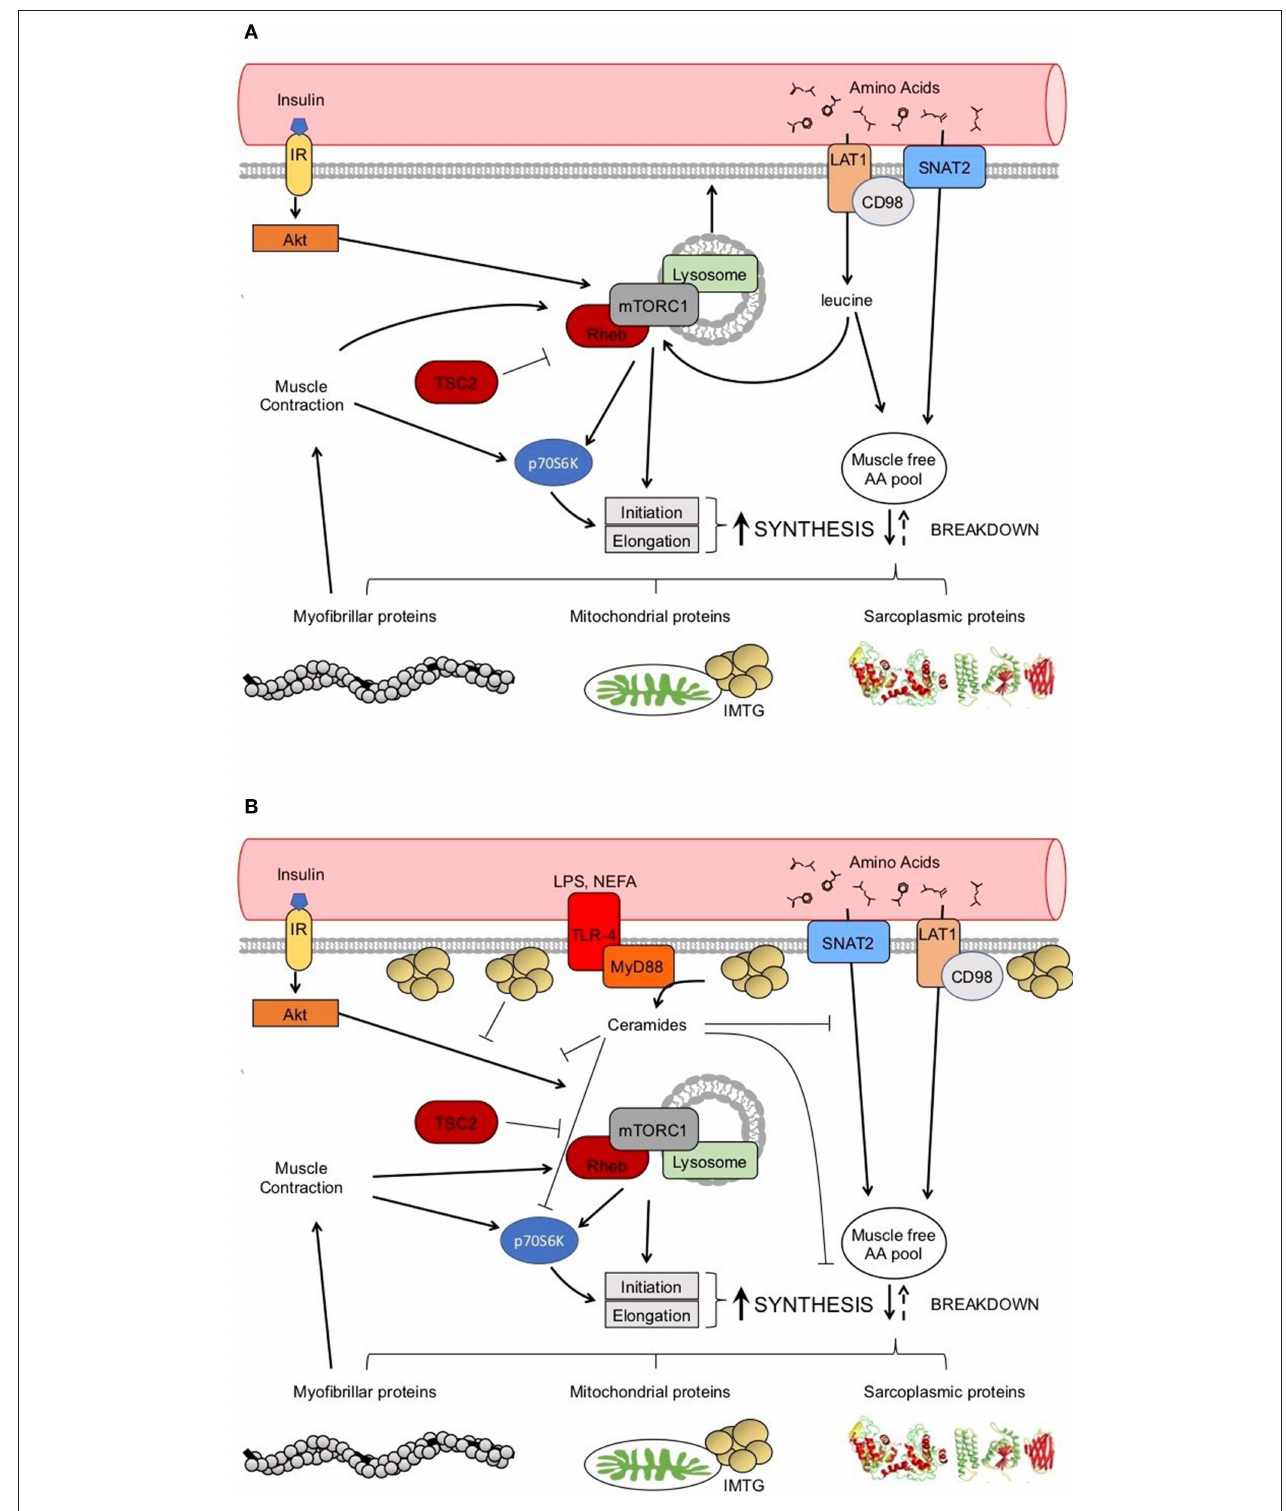
FIGURE 2 | Healthy anabolic signaling in the skeletal muscle (A) . Potential dysregulation to anabolic signaling with obesity (B) . → indicates a stimulation. ⊥ indicates an inhibition.